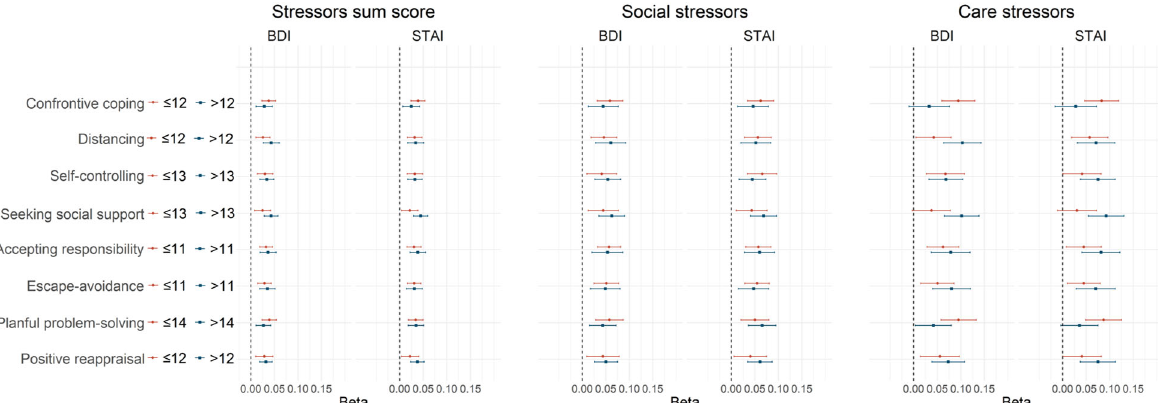
Fig. 3 Association between sum scores of COVID-19 related stressors and depressive and anxiety symptoms strati fi ed by coping factors. Points represent the regression coef fi cients of the linear models and bars the 95% con fi dence intervals. The BDI and STAI were standardized in order to make the estimates comparable. Models were adjusted for sex, age, disease duration, presence of comorbidities, education, living situation, region and date. The strati fi cation variable was excluded for adjustments. All domains were dichotomized according to the median. N = 830, data on the coping questionnaire was missing in 1.7% because the participant could not imagine a stressful situation in the past twelve months.